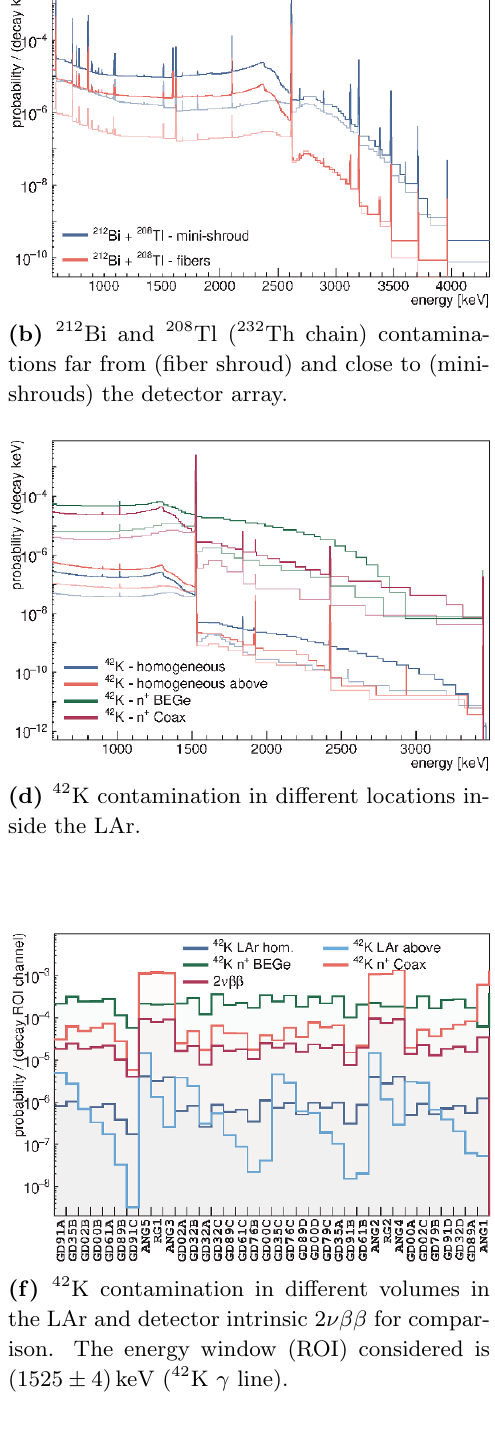
Figure 3. From (a) to (e): PDFs in the full energy domain. The PDFs for the M1-enrGe ( M1-enrBEGe + M1-enrCoax ) (in fully opaque colors) and the M2-enrGe (in shaded colors) data sets relative to di(cid:11)erent background sources. For visualization purposes a variable binning is adopted. (f) PDFs per detector for the 42 K (cid:13) line. All PDFs are normalized to the number of simulated primary decays.